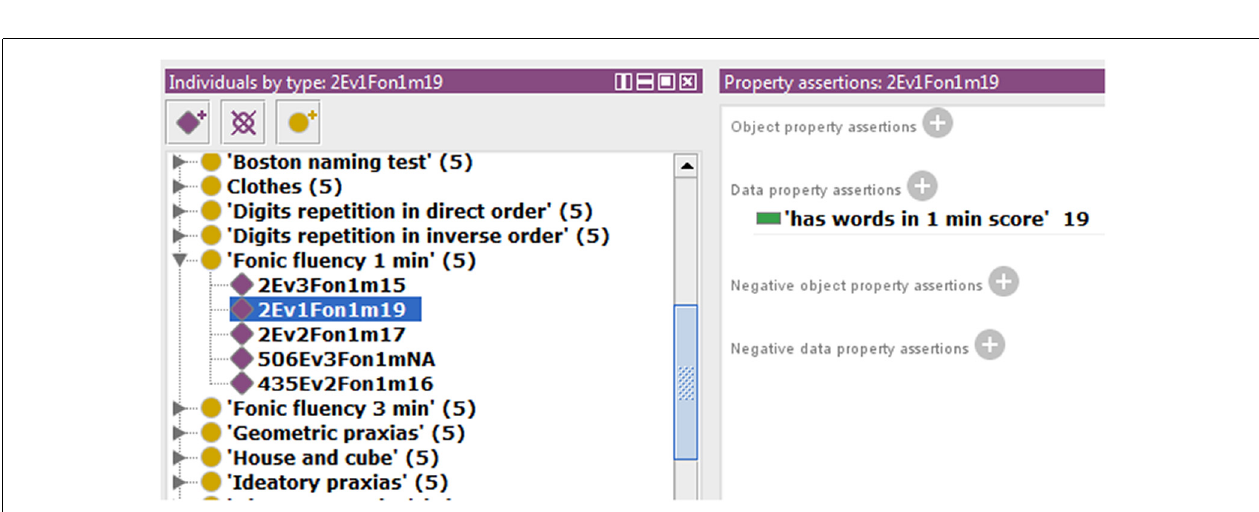
FIGURE 4 | Example of instantiation in Neurocognitive Integrated Ontology (NIO), showing the value entered under instance 2Ev1Fon1m19, which corresponds to the score obtained by subject 2 in the first evaluation, in the 1-min phonetic fluency